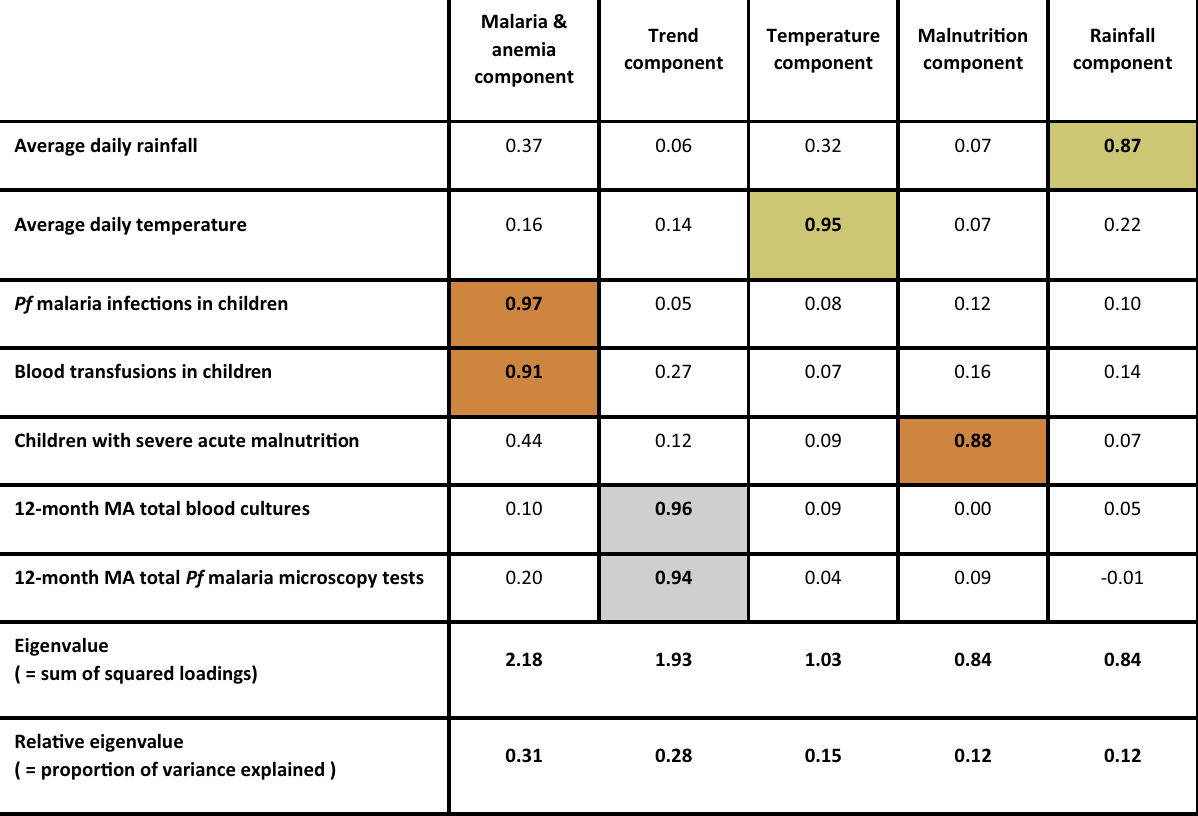
Table 1. This table summarizes the loading of the environment- (green) and host-associated factors (red) on their respective components after principal component analysis with orthogonal (quartimax) rotation to resolve multicollinearity. To adjust for the increasing trend in the number of sampled children over the years, 12-month moving averages of total blood cultures and malaria microscopy examinations (light grey) were included in